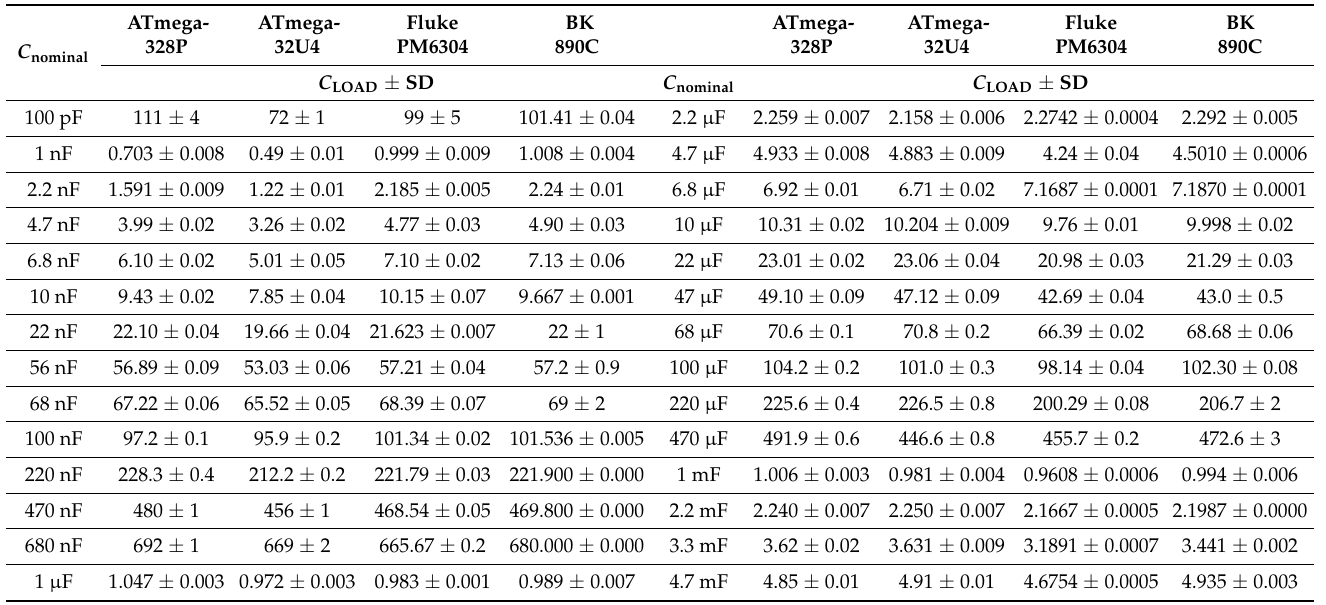
Table 5. Comparison of the ATmega328P, ATmega32U4 and Fluke 8840A measured load capacitance ( C LOAD ) values ± standard deviation (SD) through the transient acquisition